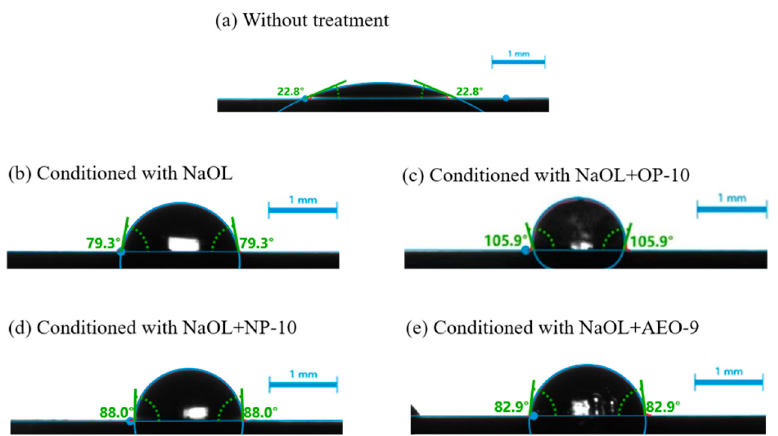
Figure 5. Contact angles of pure quartz surface ( a ) and activated quartz surface conditioned with NaOL ( b ), NaOL + OP ‐ 10 ( c ), NaOL + NP ‐ 10 ( d ) and NaOL + AEO ‐ 9 ( e ).